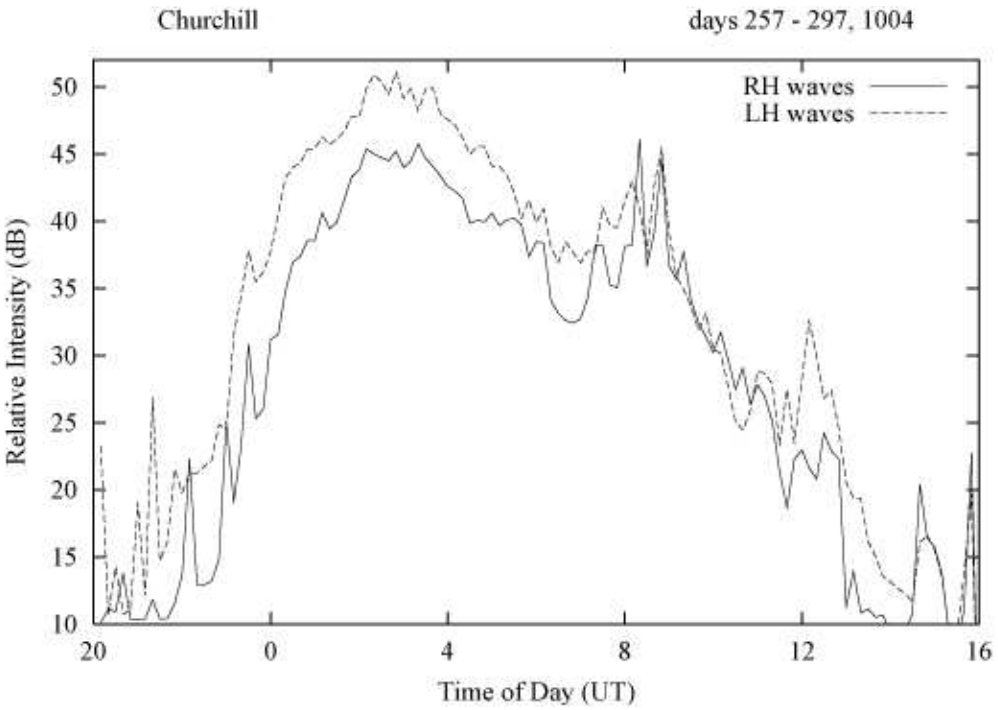
Fig. 6. Power in relative logarithmic units of left-hand (dashed trace) and right-hand (solid trace) polarized signals received at Churchill, Manitoba, integrated over the frequency range 3600–4500kHz and averaged over the 40-day interval from day 257 to day 297, 1997, as a function of time of day. During 22:00–08:00 UT and 11:00–15:00 UT, left-hand signals exceed right-hand signals by about 3dB; During 08:00–11:00 UT (02:00–05:00 MLT) right-hand and left-hand signals have approximately equal amplitudes. Geographic local midnight is at 06:19